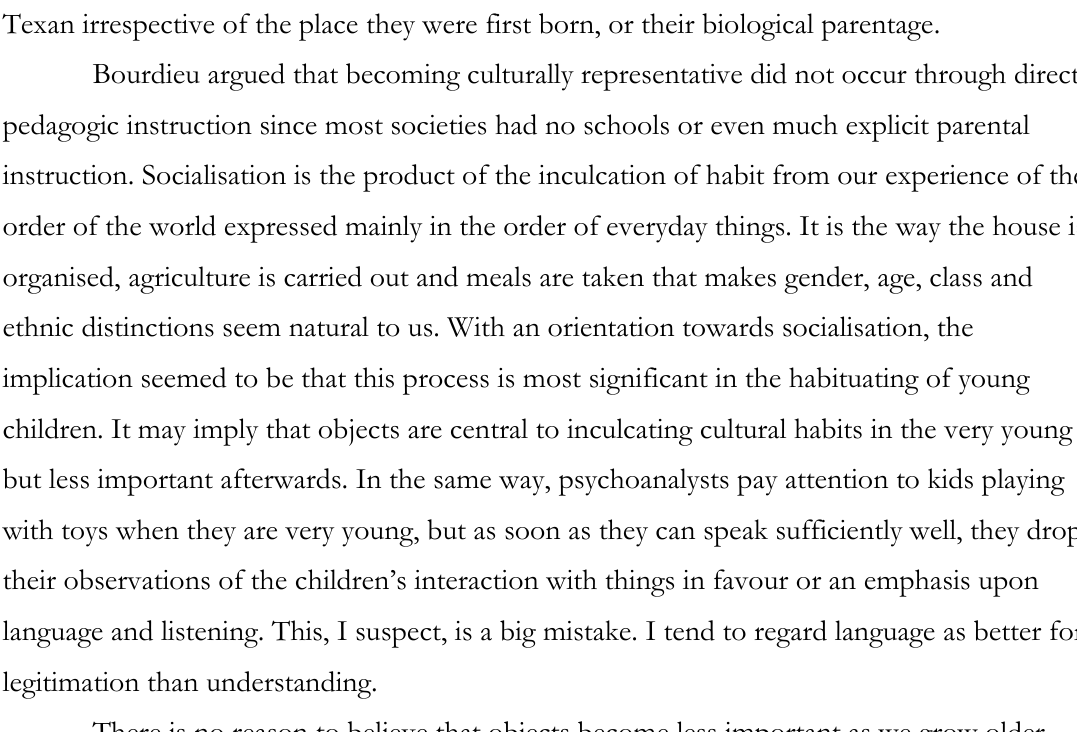
Daniel Miller: Getting THINGS Right: Motherhood and Material Culture Studies in the Maternal, 3(2), 2011,